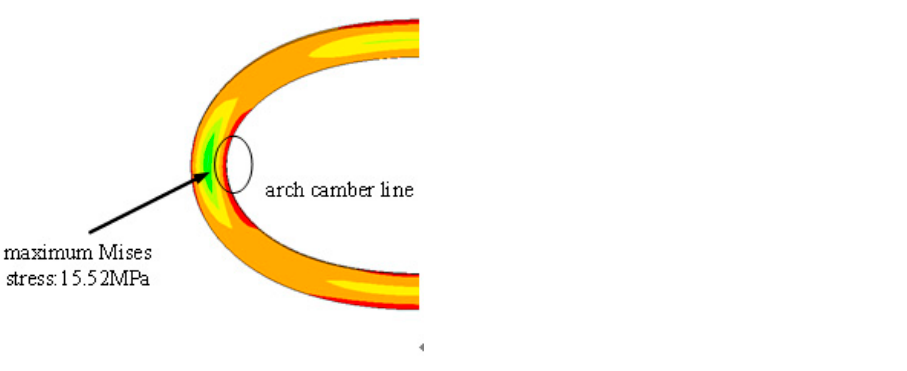
Figure 8. Maximum von Mises stress along the arch camber line in intact pipeline with no defect.